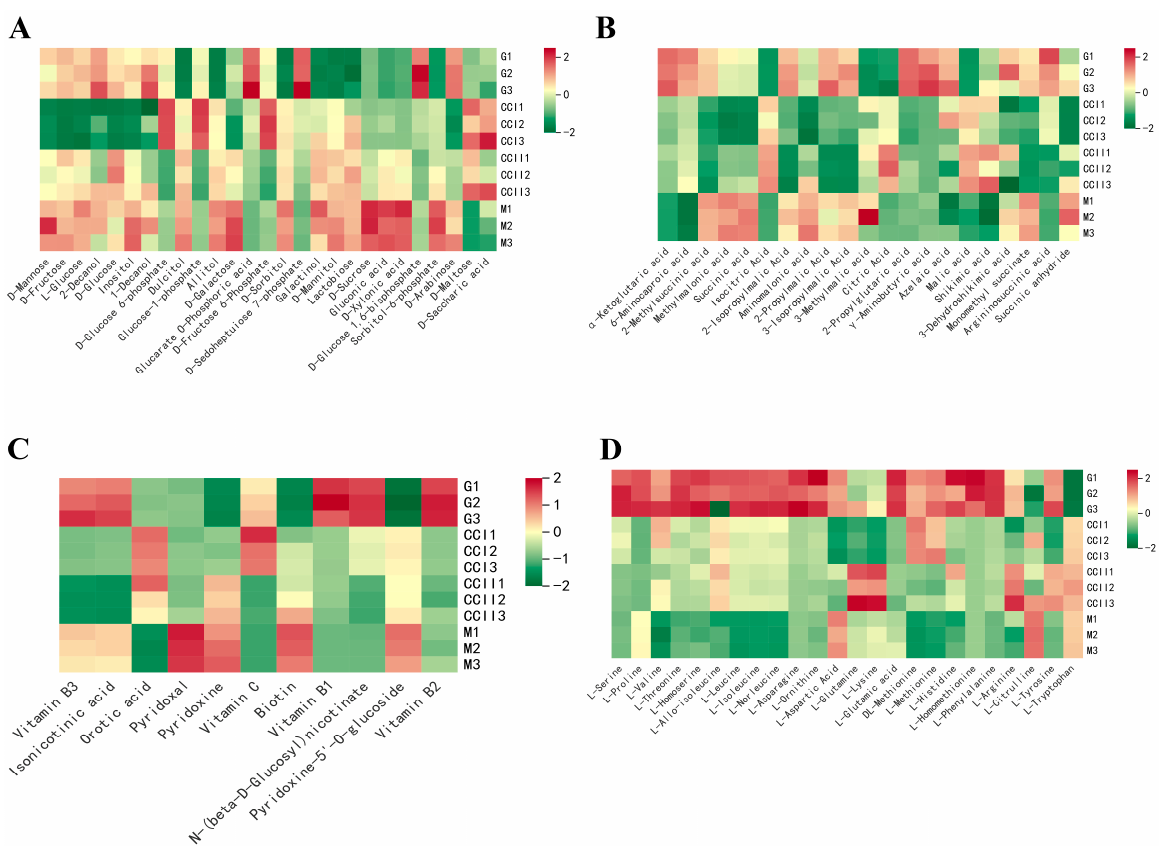
Figure 3. Primary metabolites detected by UPLC-MS/MS during four fruit developmental stages. ( A ): Saccharides and alcohols; ( B ): Organic acids (and its derivatives); ( C ): Vitamin; ( D ): Amino ac-